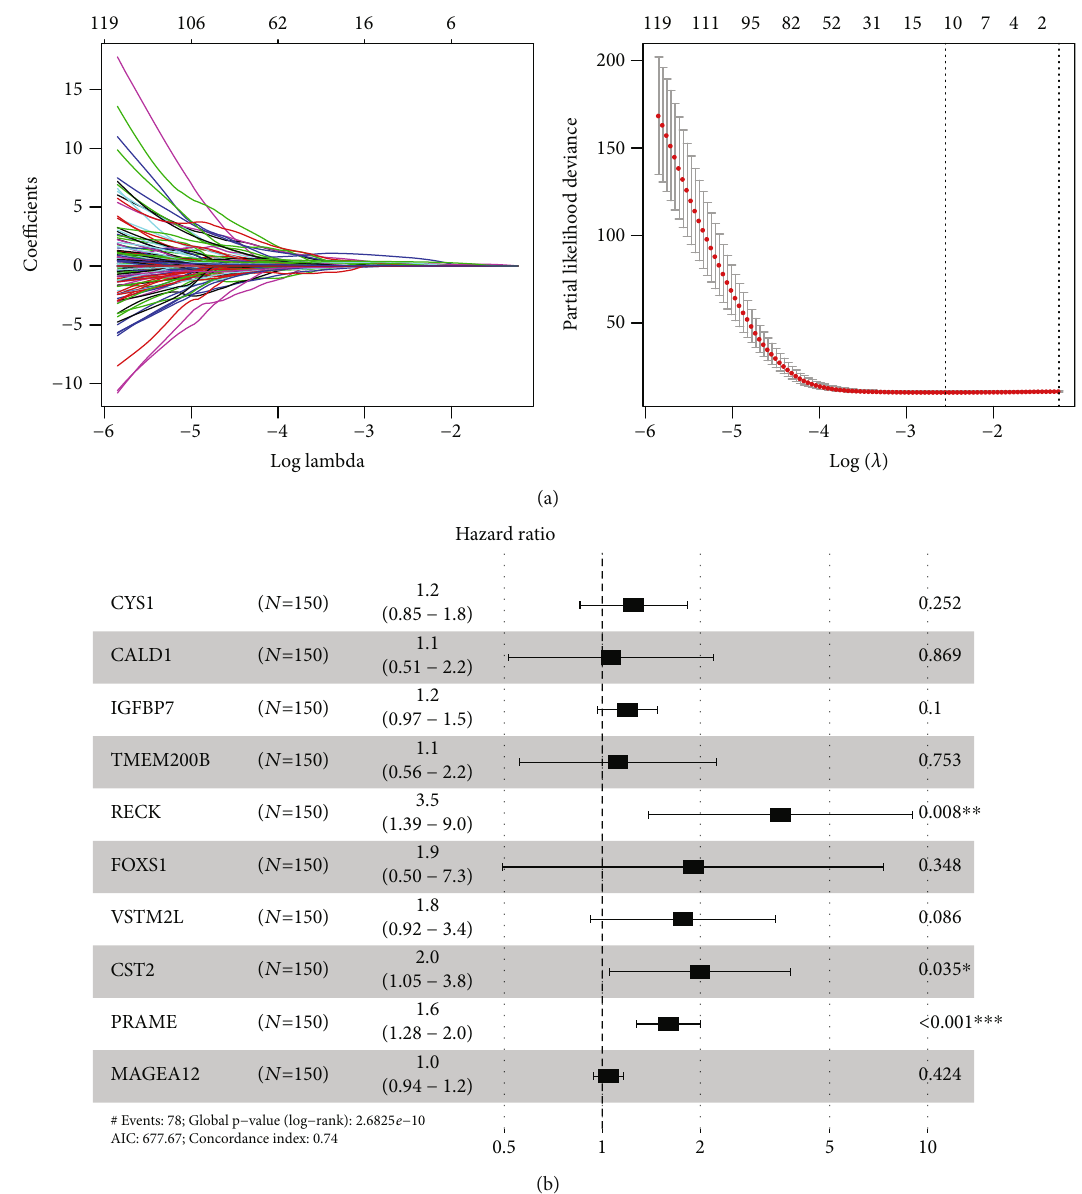
1.0 (0.94 − Figure 9: